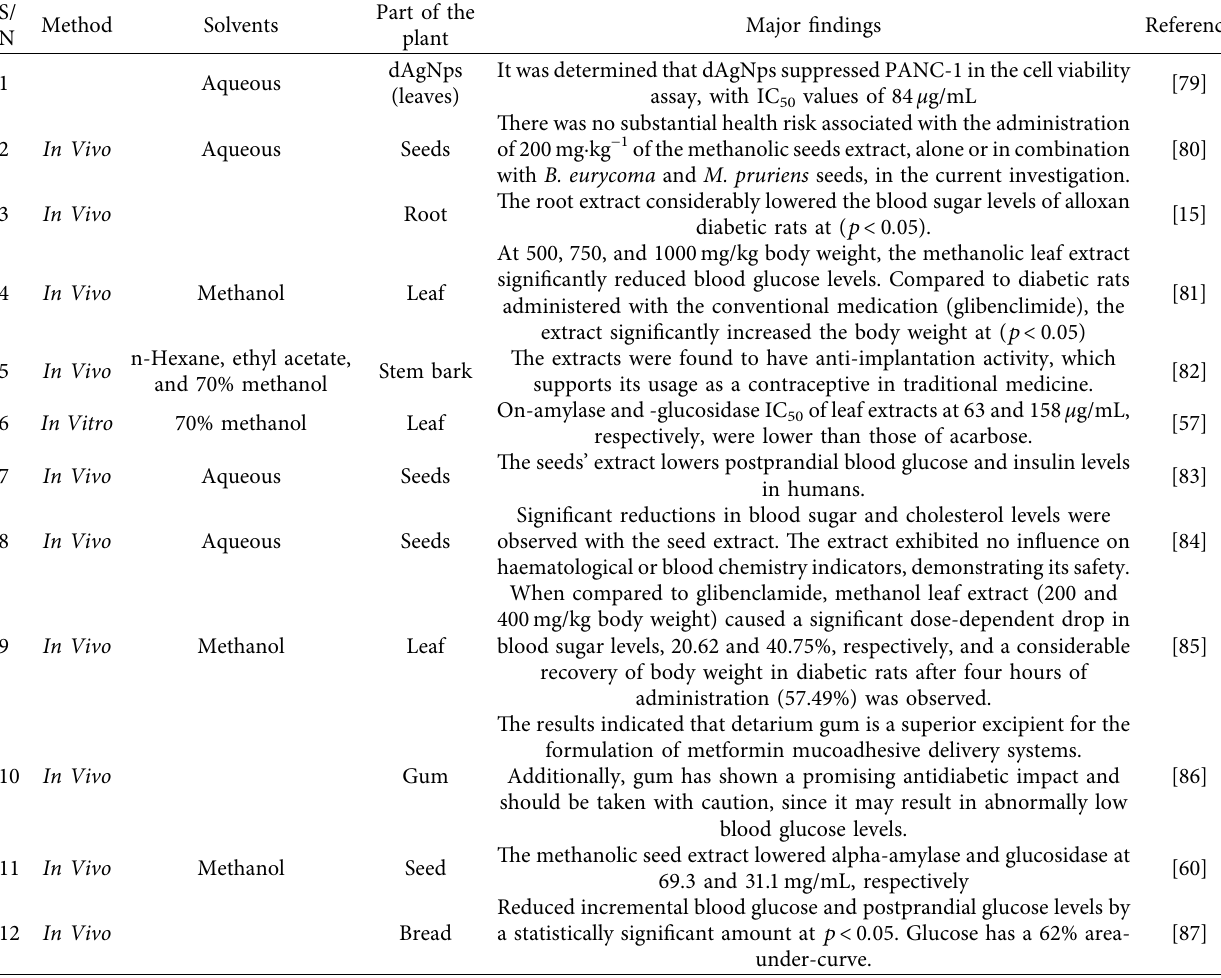
Table 7: Antidiabetic activity of D. microcarpum .